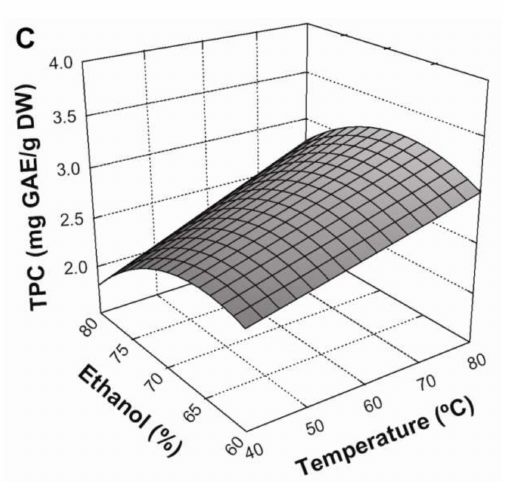
Figure 1. Response surface plots showing the effects of ethanol concentration and liquid/solid ratio ( A ), extraction temperature and liquid/solid ratio ( B ), and extraction temperature and ethanol concentration ( C ) on the extraction yield of TPC in BSG extracts. The missed variable in each graph was kept at the centre